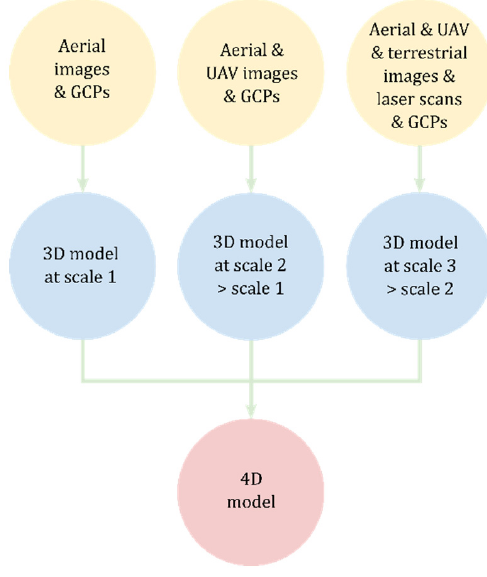
Figure 6. 4D modelling